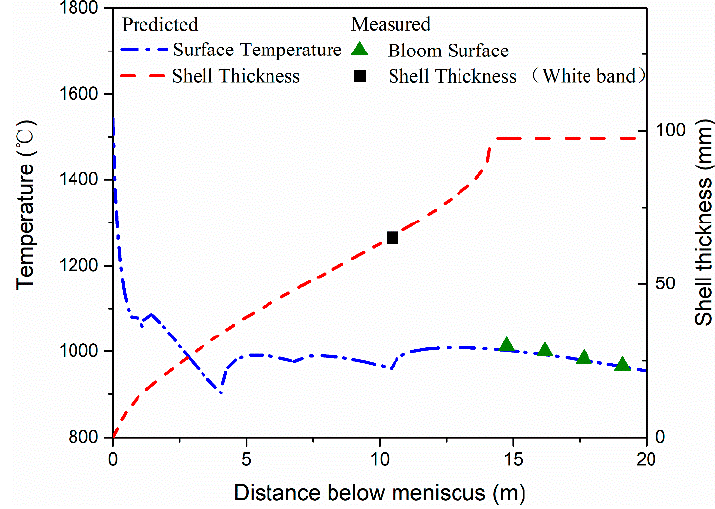
Figure 3. Comparison between the predicted and measured surface temperature and shell thickness.